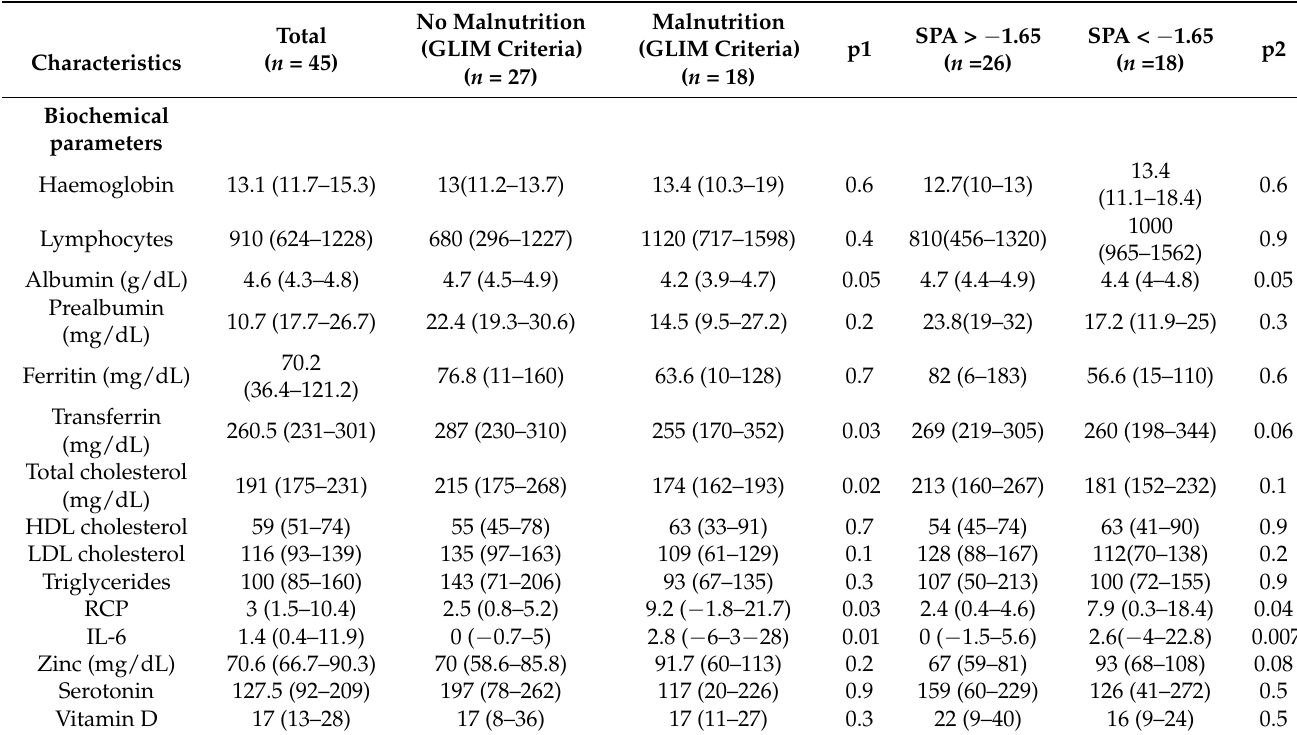
Table 3. Biochemical analysis of the evaluated cohort. Comparison between groups based on the presence of malnutrition according to the Global Leadership Initiative on Malnutrition (GLIM) criteria or a standardized phase angle < −